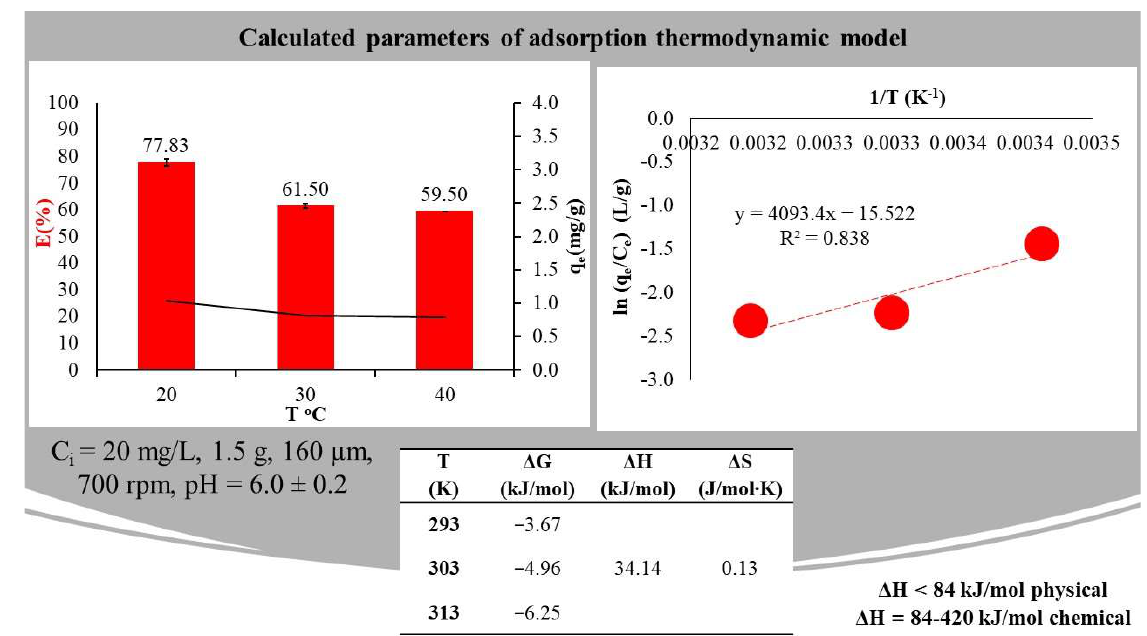
Figure 2. The effect of temperature on adsorption and thermodynamic parameters, with standard deviations calculated from nine experiments and their measurements.